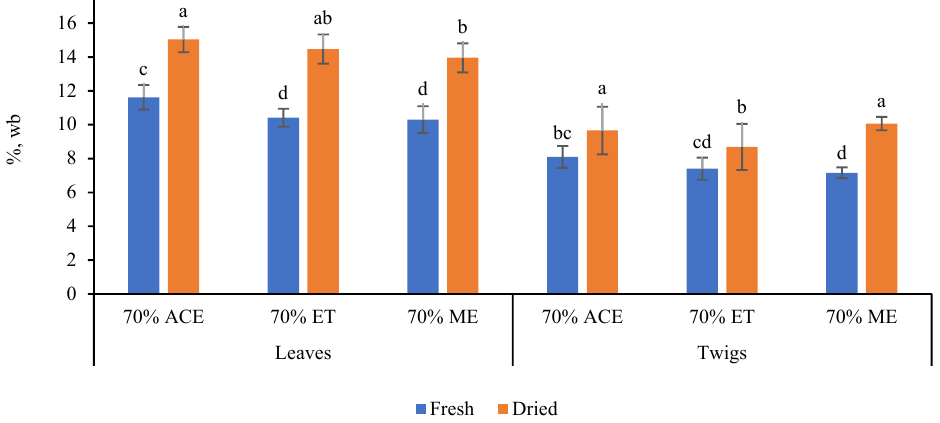
Figure 1. Comparison of the average extraction yields for fresh and dried leaves and twigs (regardless the extraction method and the provenience of the raw material); different letters indicate significant differences of means (one-way ANOVA, Tukey test at p < 0.05).